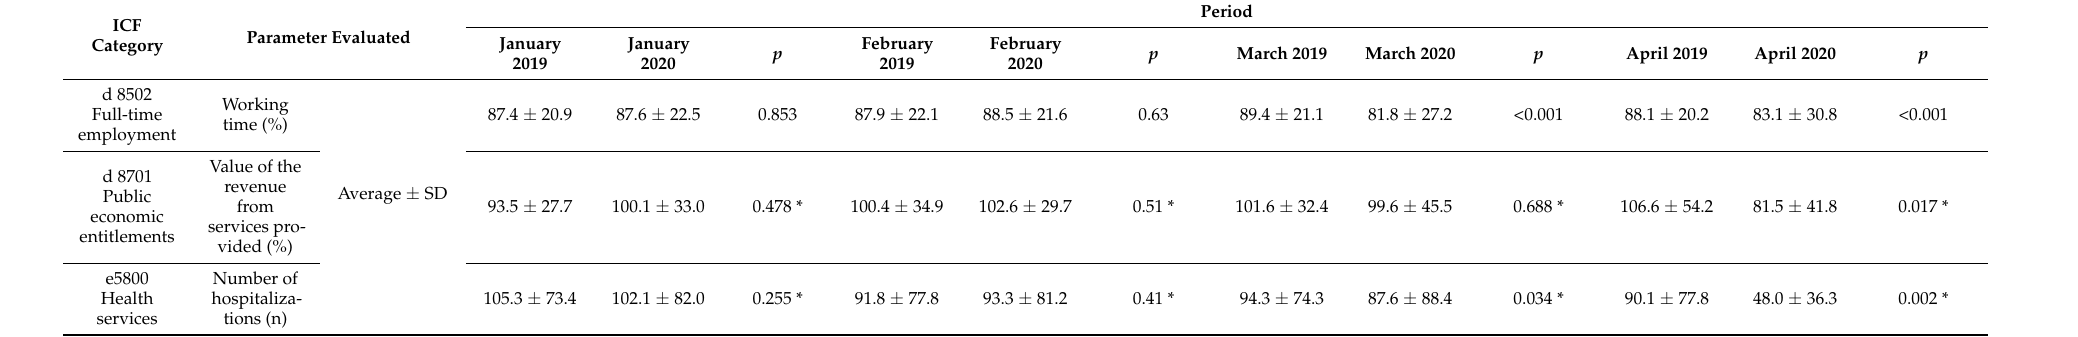
Table 1. Statistical analysis of the operation of the hospital in Q1 2019 and